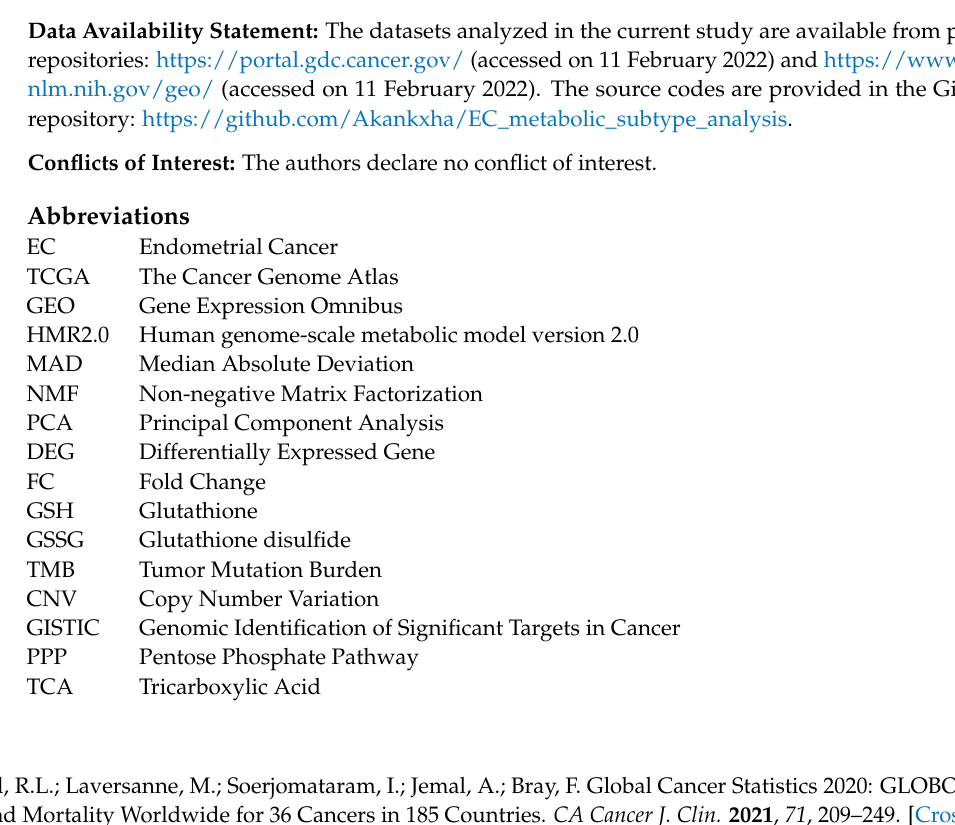
results; Figure S2: Reporter metabolites involved in lipid metabolism; Figure S3: Validation of metabolic subtypes in an independent GEO dataset; Table S1: NMF results with different number of input genes; Table S2: Fisher exact test and Cramer’s V results; Table S3: Summary of average mutation types; Table S4: Survival analysis of frequently mutated genes; Data S1: List of differentially expressed and prognostic